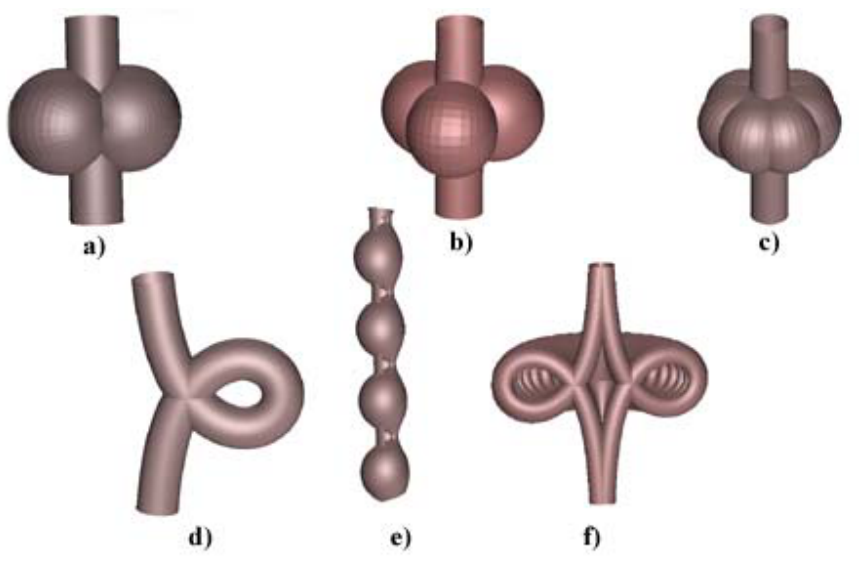
˜ X cγ which satisfy the relation − 1 / 2 + H + γ K = 0 Fig. 4 – Complete Weingarten surfaces and are associated to the cylinder by Ribaucour transformations. a) 1-periodic cmc surface √ √ γ = 0 and 1 − c = 2; b) 1-periodic cmc-surface for which γ = 0 , 1 − c( 2 γ + 1 ) = √ 3 / 2; c) 1-periodicWeingarten surface, γ = 0 . 15, 1 − c( 2 γ + 1 ) = 7 / 5 ; d) tubular surface, γ = − 1 / 2 , c = − 0 . 1; e) cmc surface (not periodic) where c = 1 . 5 and γ = 0; f) part of a complete hyperbolic